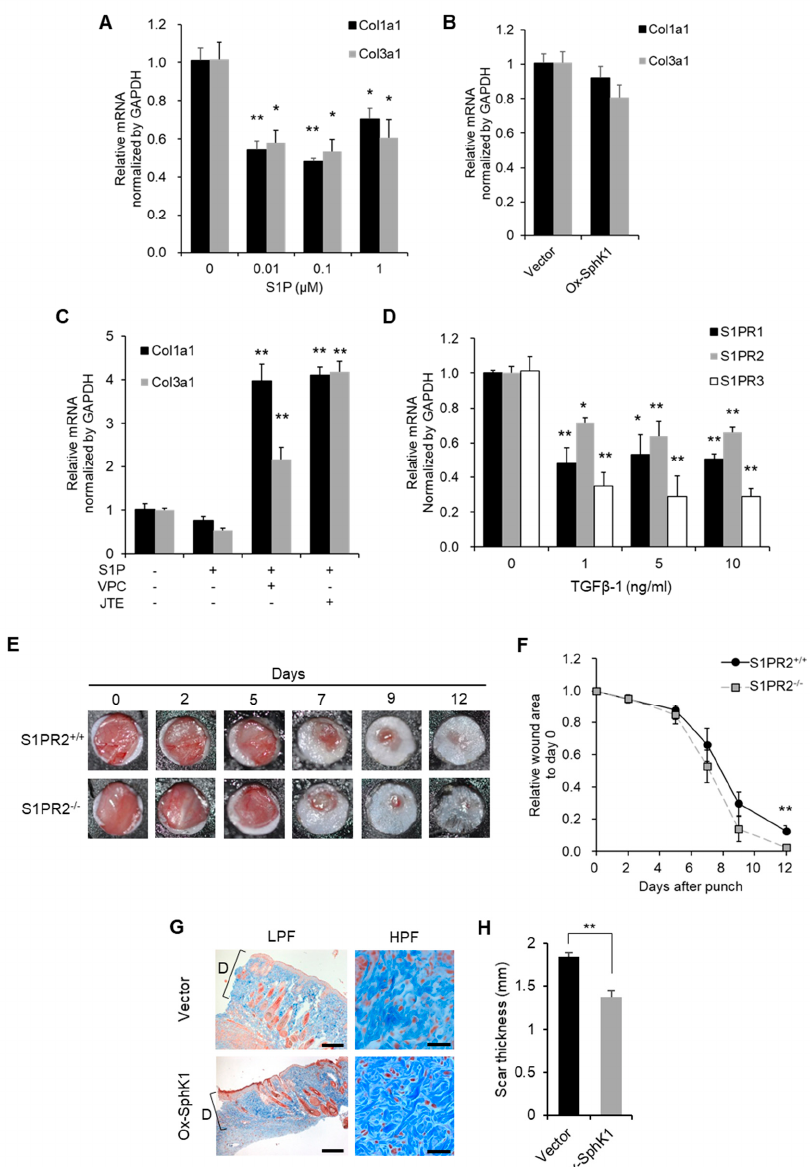
Figure 7. Topical SphK1 gene delivery inhibits scarring. The mRNA expression of Collagen1a1 and Collagen3a1 in NIH3T3 cells ( A ) stimulated with the indicated concentration of S1P for 24 h ( n = 4) or ( B ) transfected with SphK1-expressing plasmid or vector plasmid ( n = 4). ( C ) The mRNA expression of Collagen1a1 and Collagen3a1 in NIH3T3 cells stimulated with 1 µM S1P for 24 h with or without 10 µM VPC23019 (inhibitor of S1PR1 and S1PR3) or JTE013 (inhibitor of S1PR2) ( n = 3). ( D ) The mRNA expression of the indicated S1PRs in NIH3T3 cells stimulated with the indicated concentration of transforming growth factor (TGF)- β 1 for 18 h ( n = 3). ( E ) Splinted excisional wounds were generated in S1PR2 − / − and S1PR2 +/+ mice. Representative images of the closing wounds are shown. ( F ) The wound area over time was measured ( n = 6). ( G ) Representative images of Masson’s trichrome-stained scars at the point of epithelization after treatment with sCA-encapsulated plasmid ointment (the scale bars are LPF: 400 µ m; HPF: 50 µ m). “D” indicates the scar thickness. ( H ) The scar thickness was measured and graphed ( n = 4–6). All values in this figure represent the mean ± s.e.m. * p < 0.05, ** p <